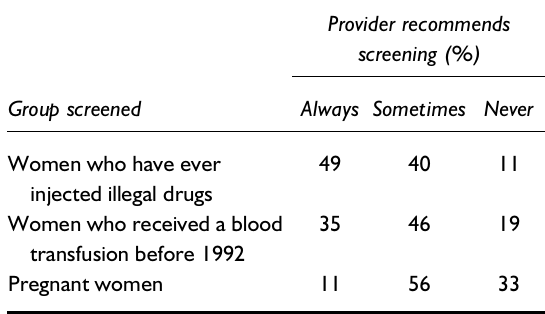
Table 1 Demographic and practice characteristics of Table 2 Groups screened and approximate